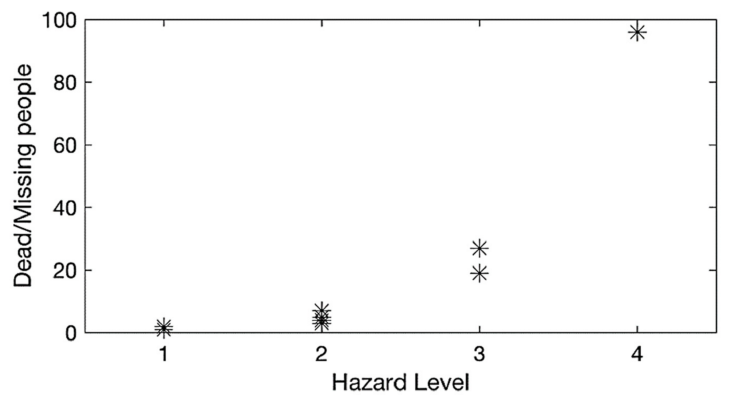
Figure 12. Levels of 14 flash flood hazard events ( ∗ ). A larger level means more severe